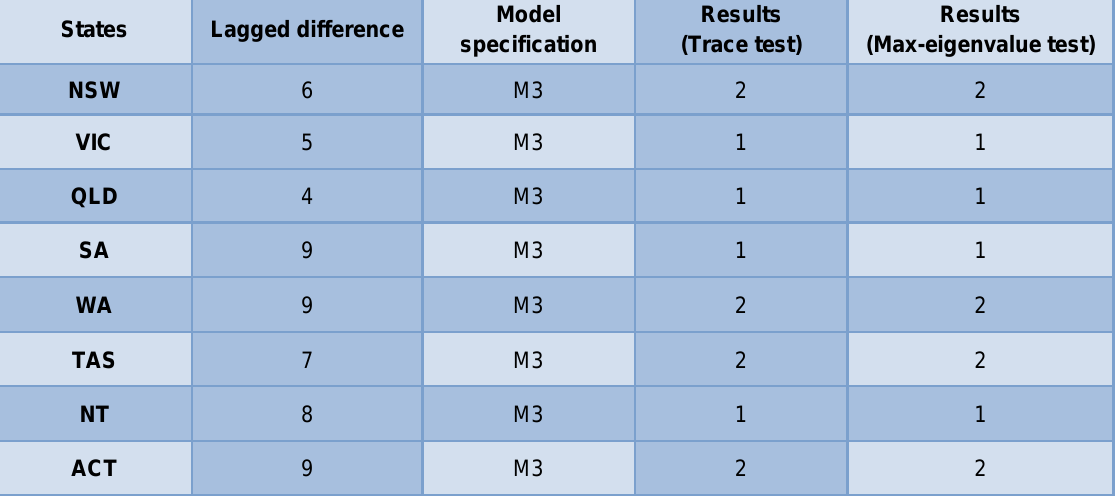
Table 3: Summary of the JJ test results of construction output